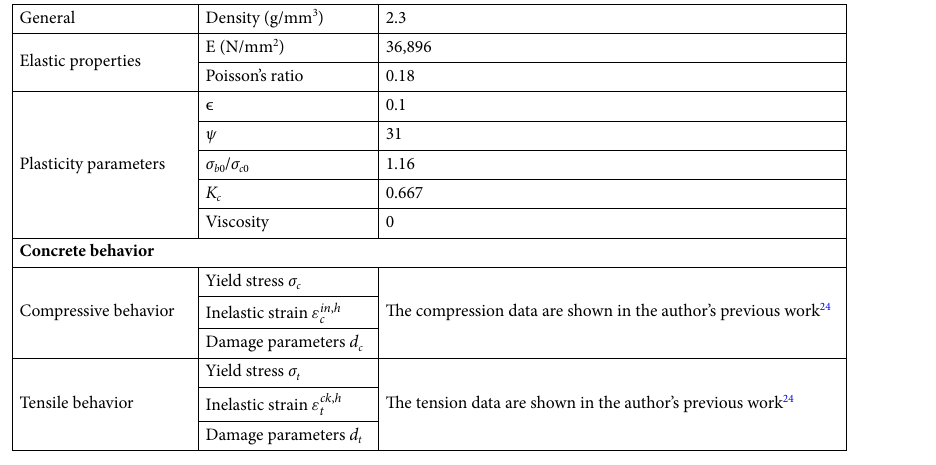
Table 3. The input parameters in ABAQUS